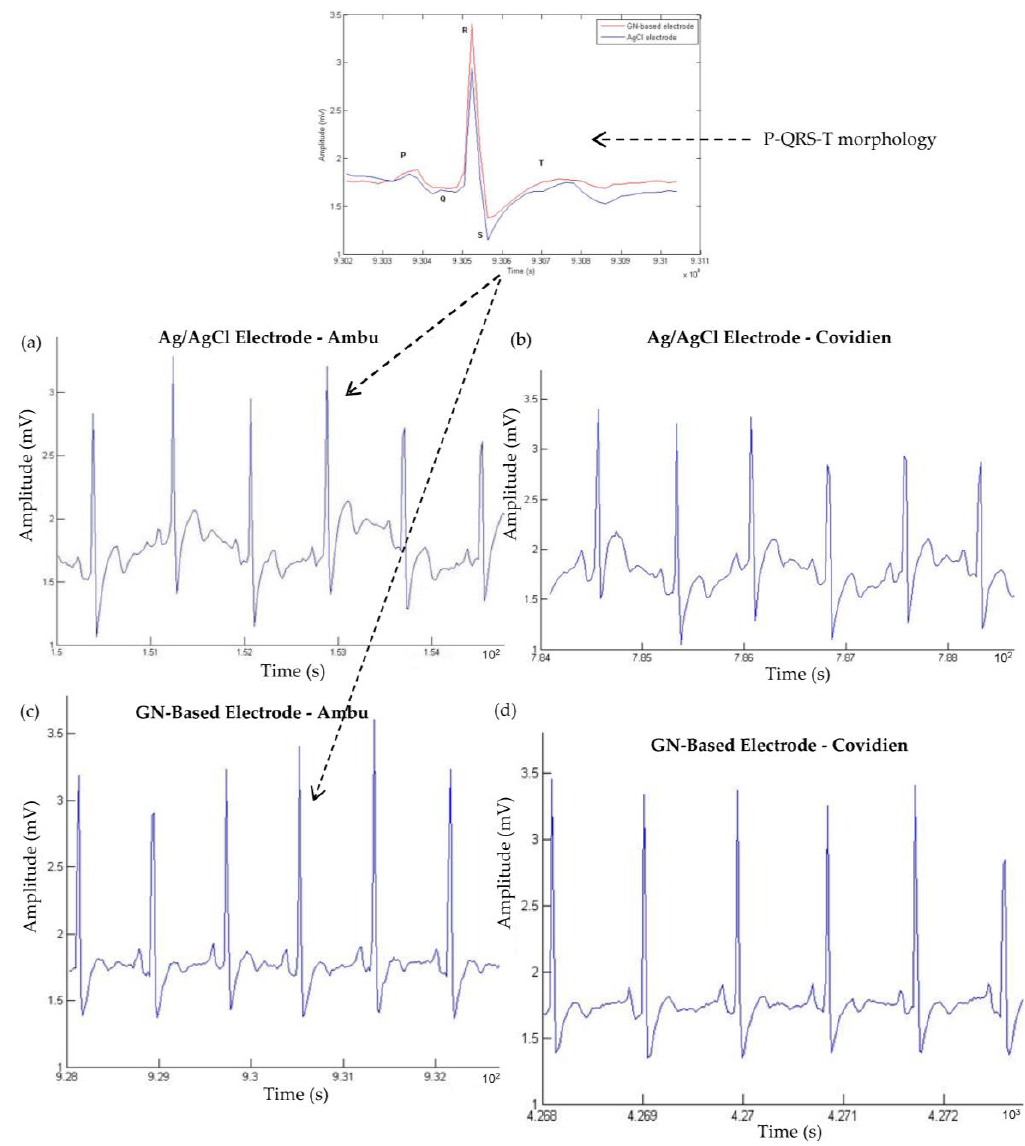
Figure 9. Chest-based ECG signals from the Ag/AgCl electrode and from the GN-based